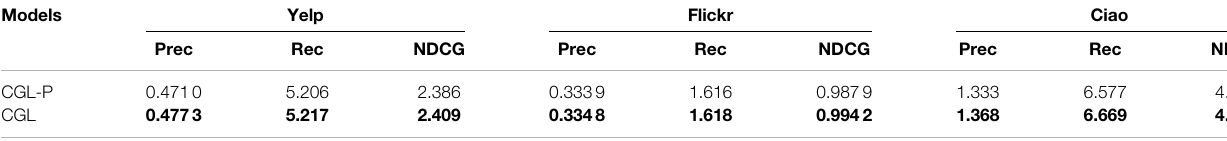
TABLE 8 | Comparison of CGL and its variant with different pointwise loss positions ( K = 20). The best results are in bold. Models